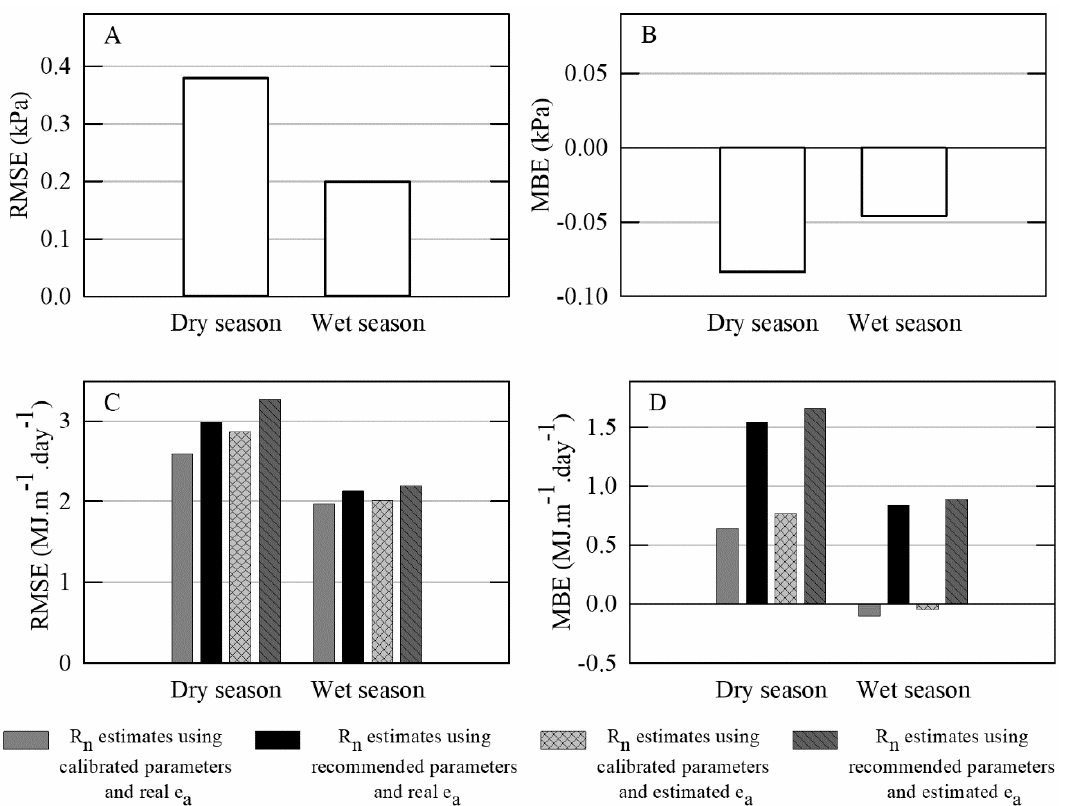
Figure 7. ( A ) Root mean square error (RMSE) and ( B ) mean bias error (MBE) of estimated e a versus real e a ; and ( C ) root mean square error (RMSE) and ( D ) mean bias error (MBE) of estimated R n in comparison with measured R n − G . The legend of colors and patterns is the same for both graphs ( C ) and ( D ).